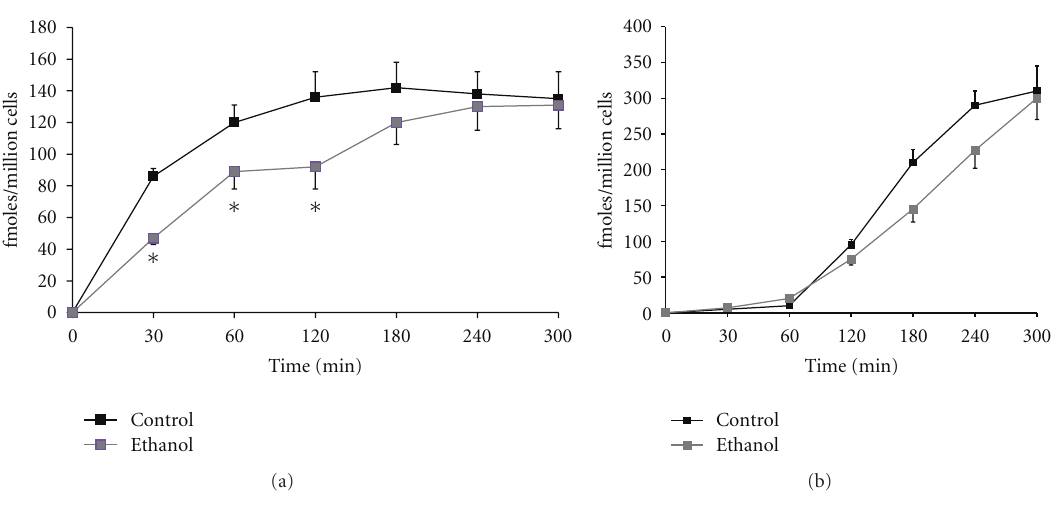
Figure 2: Kinetics of internalization (a) and degradation (b) of 125 I-ASOR in HAD cells after 7 days of treatment with 25 mM ethanol. Cells were treated with ( (cid:2) ) or without ( (cid:3) ) ethanol for 7 days as previously described. At the end of the treatment period, cells were incubated with Eagles medium containing 1% BSA and 2ug per mL iodinated ASOR. At the indicated times, duplicate plates were removed from the 37 ◦ C incubator, the cells were removed from the plates with 2mM EDTA, and internalization (pellet associated, a) and degradation (acid-soluble media radioactivity, b) were determined. Data are presented as fmoles internalized or degraded per million cells and are means ± SEM for 6–10 experiments. Values significantly di ff erent from controls are indicated, ∗ P < 0 .